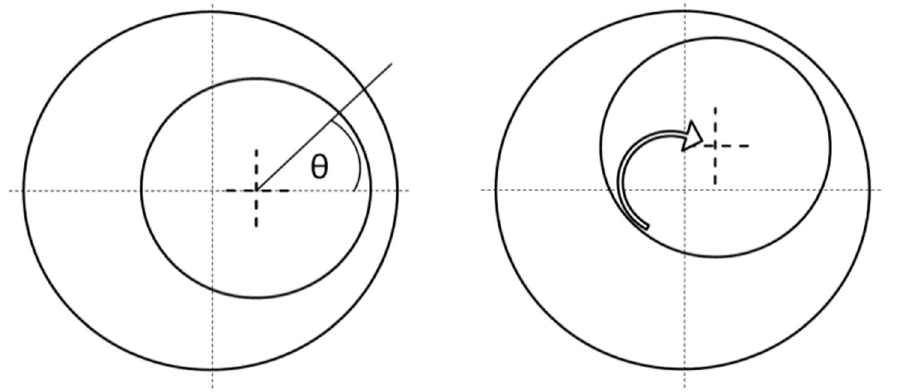
Figure 2. Depiction of static and dynamic eccentricity of the motor.